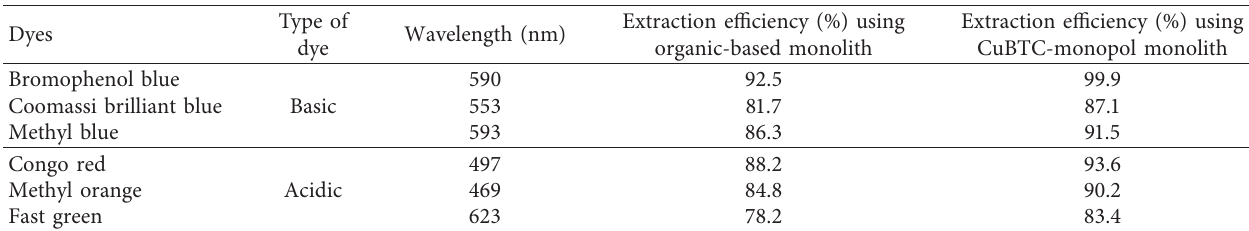
Table 2: Extraction efficiency percent of the investigated dyes from potentially polluted groundwater samples using organic-based monolith and CuBTC-monopol monolith.